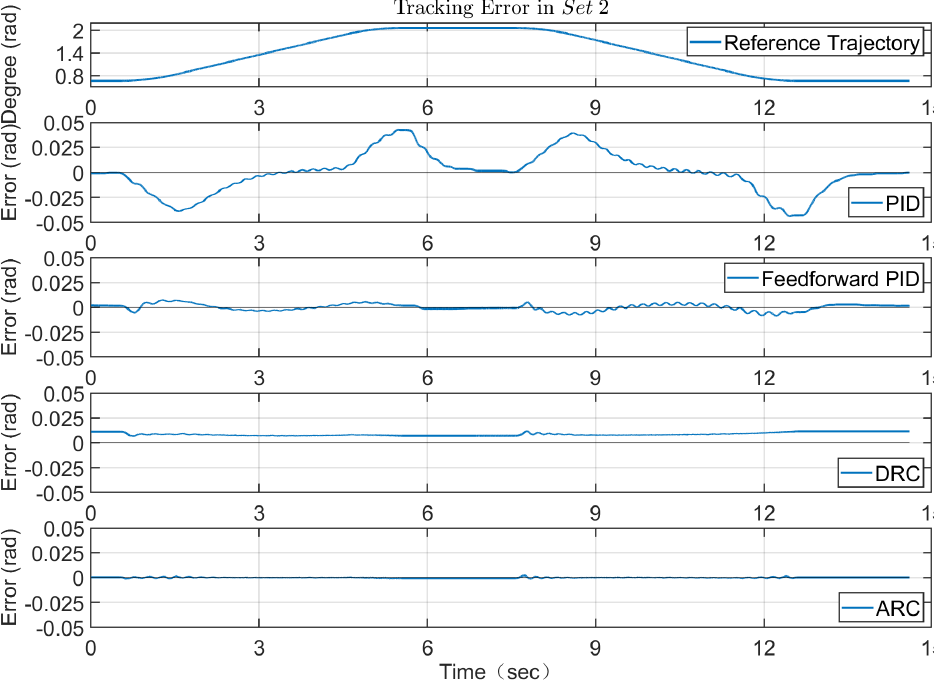
Figure 5. Point-to-point trajectory tracking error comparison diagram with Posture